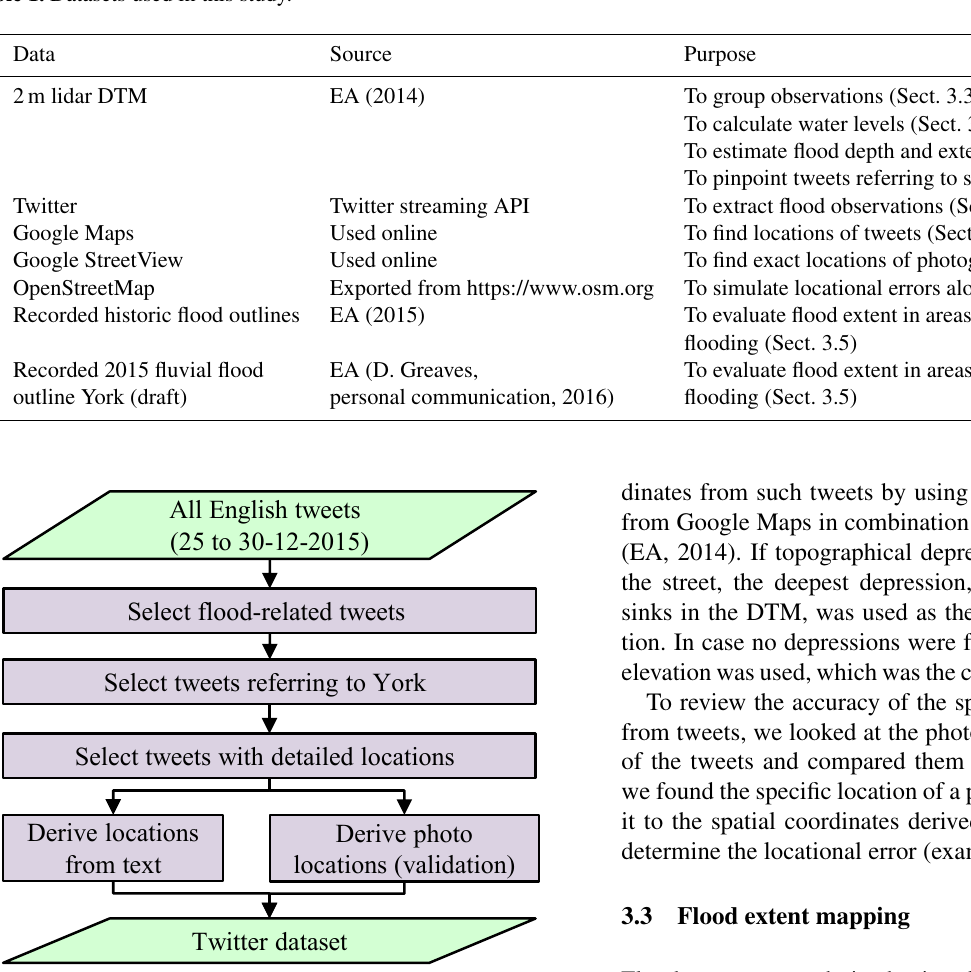
Table 1. Datasets used in this study.